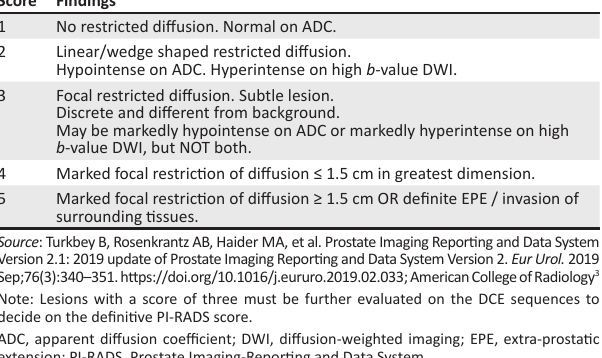
TABLE 2: PI-RADS assessment of prostatic lesions according to diffusion- weighted imaging characterisation. Score Findings